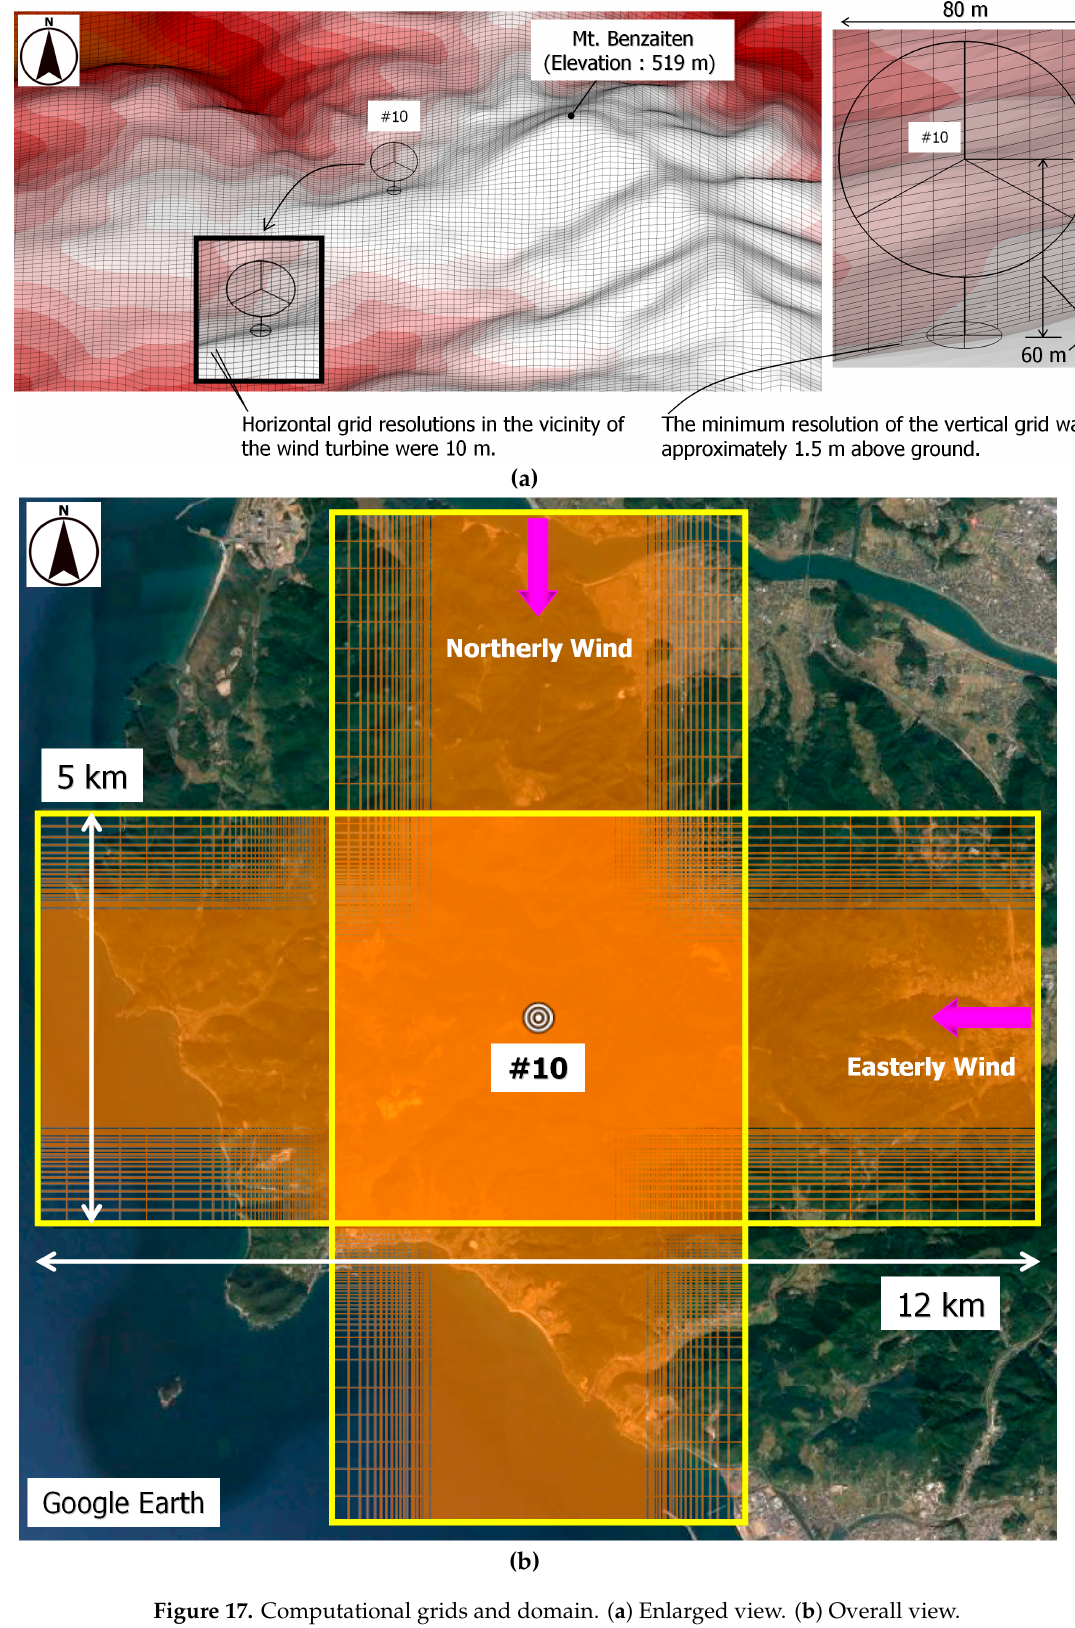
Figure 17. Computational grids and domain. ( a ) Enlarged view. ( b ) Overall view. The power law distribution was provided with N = 7.0, which is shown in Figure 18, regarding the inlet boundary conditions of numerical wind simulations. The present study focused on the